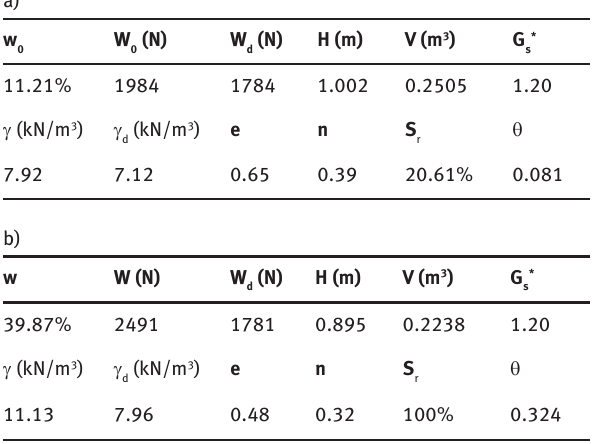
Table 3: Physical-volumetric parameters of the coal in the prototype model: a) at initial state; b) after volumetric collapse